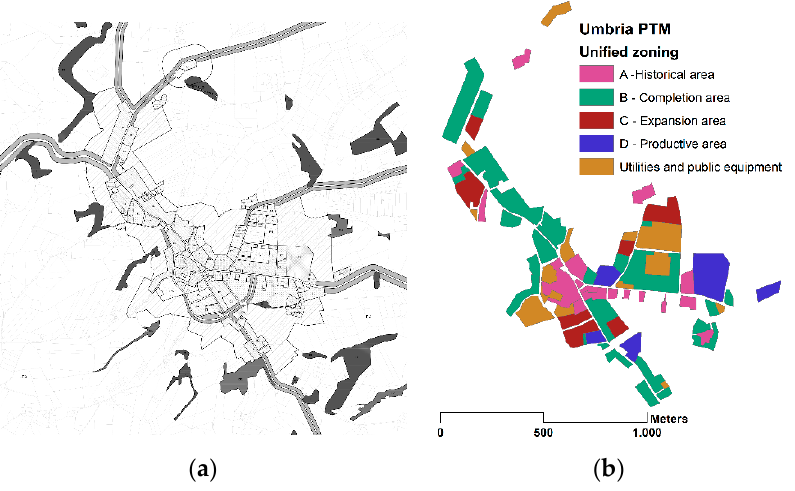
Figure 10. Example of development of conversion from the original configuration ( a ) of the plan to the version of settlement contents with a unified legend for regional PTM ( b ).